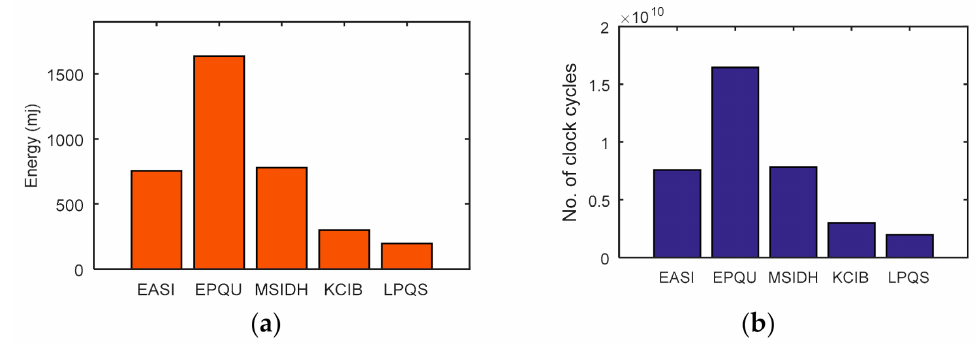
Figure 9. ( a ) Energy consumption; ( b ) clock cycle comparison with isogeny based postquan- tum schemes.